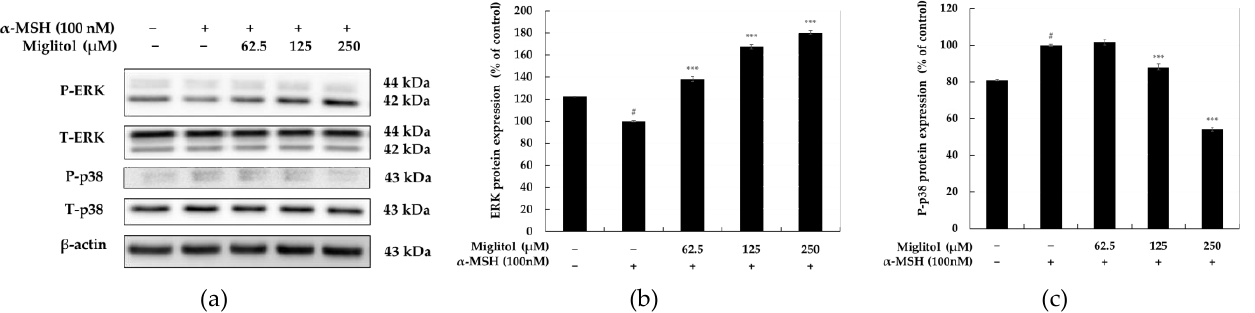
Figure 6. The effect of miglitol on MAPK protein expression in α -MSH-stimulated B16F10 cells. Cells were treated with miglitol (62.5, 125, and 250 µ M) for 4 h in the presence of α -MSH (100 nM). ( a ) Western blotting results and ( b ) p-ERK, and ( c ) p-p38 protein expression. α -MSH was used as the negative control. The results are presented as the mean ± SD from three repeated measurements using ImageJ. # p < 0.001 vs. the unstimulated control group; *** p < 0.001 vs. α -MSH alone.